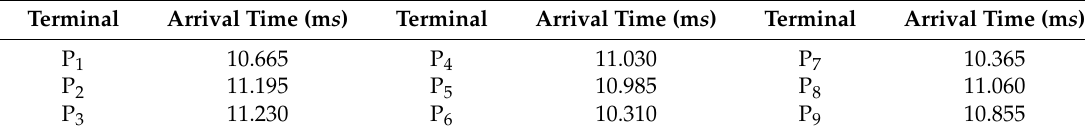
Table 5. Arrival times of the initial traveling wave for fault F3 with fault initialization time = 0.01 s.